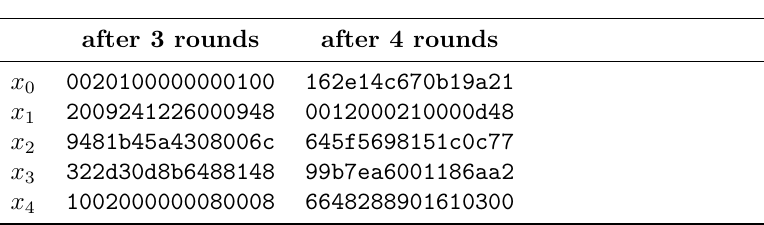
Table 16: Differential characteristic LB4.1. The probability of this characteristic is 2 − 109 . The breakdown of the probability (in − log